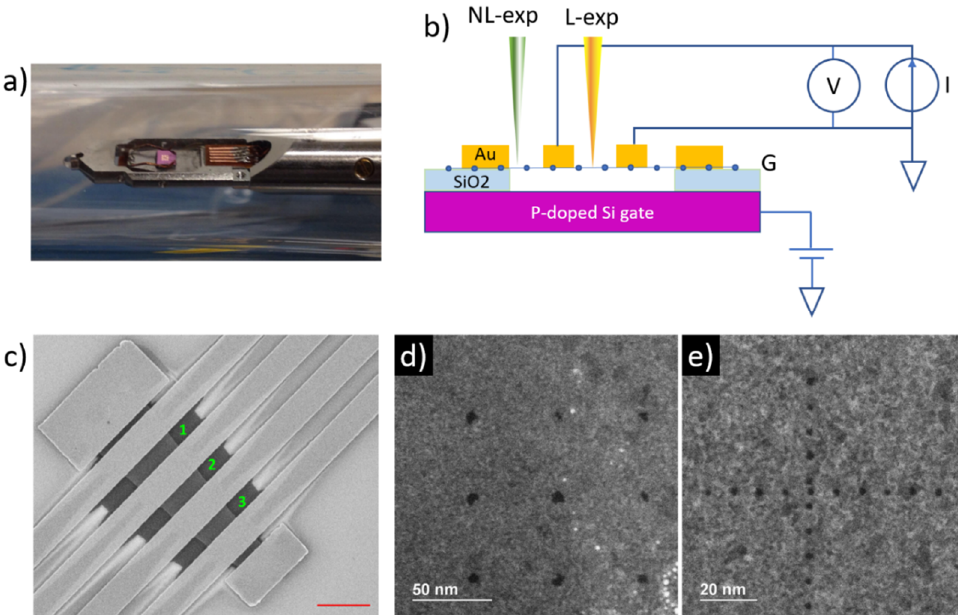
Figure 1. ( a ) Home-modified scanning transmission electron microscope (STEM) holder with five electrodes. ( b ) Schematic showing in situ measurement of a suspended graphene device. The labels “NL-exp” and “L-exp” in the electron beams denote “non-local” and “local” exposure situations, respectively. ( c ) Scanning electron microscope (SEM) micrograph of a finished device. Numbers indicate three electrically independent suspended graphene channels separated by gold electrodes. Scale bar: 2 m. ( d , e ) Sub-10 nm antidots fabricated on suspended graphene via electron beam